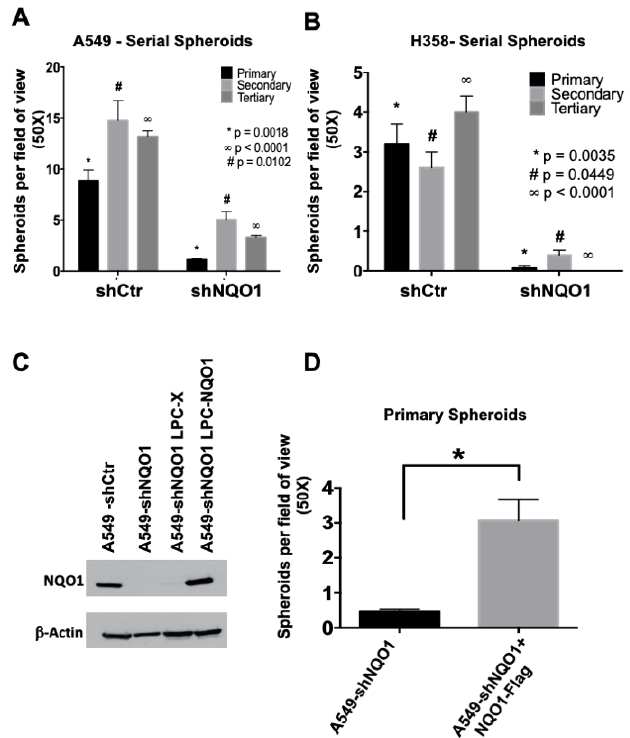
Figure 4. Loss of NQO1 expression reduces serial spheroid formation, and re-expression of NQO1 rescues tumor spheroid-forming ability. The self-renewal capabilities of lung cancer stem cells were assayed via a serial spheroid formation assay. In ( A ), A549-shCtr cells form similar numbers of spheroids in primary (black bars), secondary (light grey bars), and tertiary generations (dark grey bars), where the A549-shNQO1 cells form significantly fewer spheroids in each generation (* p = 0.0018, # p = 0.0102, ∞ p < 0.0001). The H358 cell line, as seen in ( B ), shows similar results (* p = 0.0035, # p = 0.0449, ∞ p < 0.0001). ( C ) shows the Western blot analysis of A549-shNQO1 cells transduced with the retroviral NQO1 vector in an effort to induce re-expression of NQO1 protein. ( D ) shows primary spheroid formation in NQO1 re-expressing A549-shNQO1 cells. The rescued NQO1 expression induced a significant increase in the formation of primary spheroids (* p = 0.0121). Interestingly, the impact of NQO1 loss on serial spheroid formation was more severe in H358 cells than in A549 cells, which naturally express higher NQO1 at a higher level. This result indicates that a threshold level of NQO1 expression and activity may be necessary to